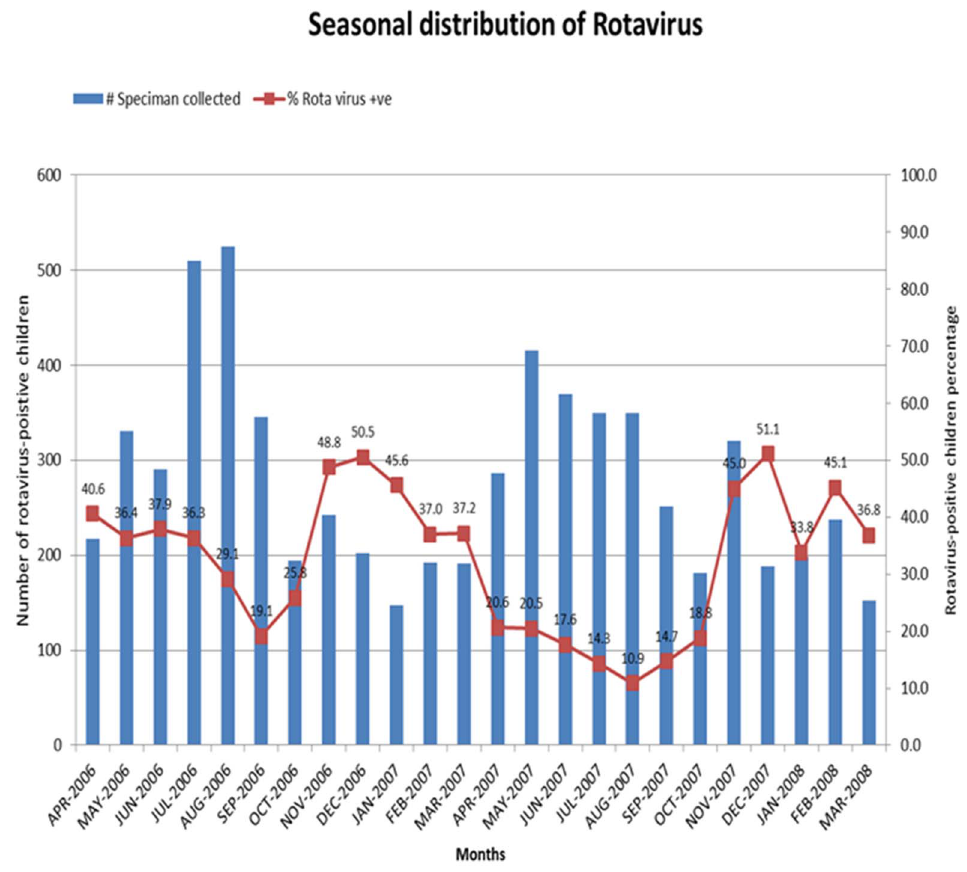
Figure 3. Distribution of rotavirus positive gastroenteritis by age in months at five sentinel hospitals in Pakistan from 2006–2008.